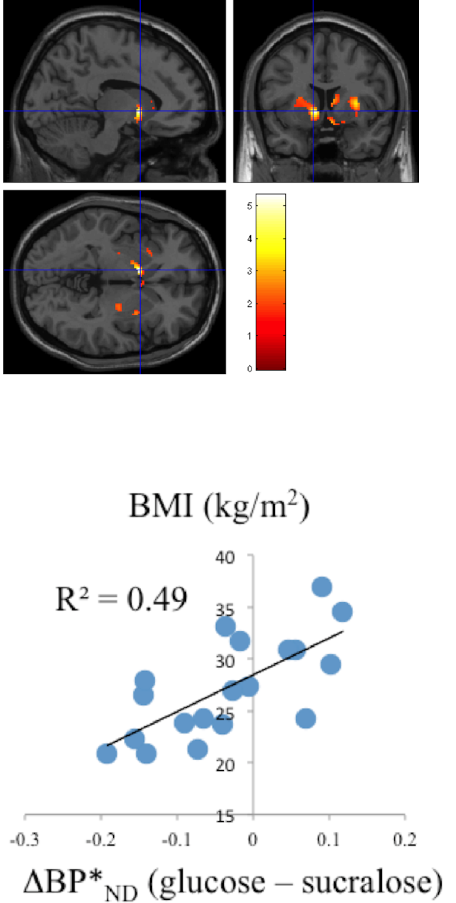
Figure 1. a: SPM images of brain dopamine changes. Significant activated clusters show dopamine (DA) changes in nucleus accumbens for the contrast glucose . sucralose intake ( D BP ND ). Note that increases in BP ND reflect DA decreases (less competition from DA for [ 11 C]raclopride to bind to D2/D3 receptors) whereas decreases in BP ND reflect DA increases with glucose (as compared to sucralose) The SPM images were superimposed onto T2 weighted MR images in sagittal (left upper), coronal (right upper) and transverse (lower) views. The color bar indicates t -score values. b: Correlation between BMI and brain DA changes. The differences between DRD2 availability after the glucose and the sucralose intake ( D BP ND ) were compared with BMI (kg/m 2 ). The leaner subjects showed the largest DRD2 decreases with glucose in nucleus accumbens (consistent with DA increases) whereas the heavier subjects showed DRD2 increases (consistent with DA decreases). D BP*: corrected for changes in blood glucose levels (glucose – sucralose) within PET acquisition